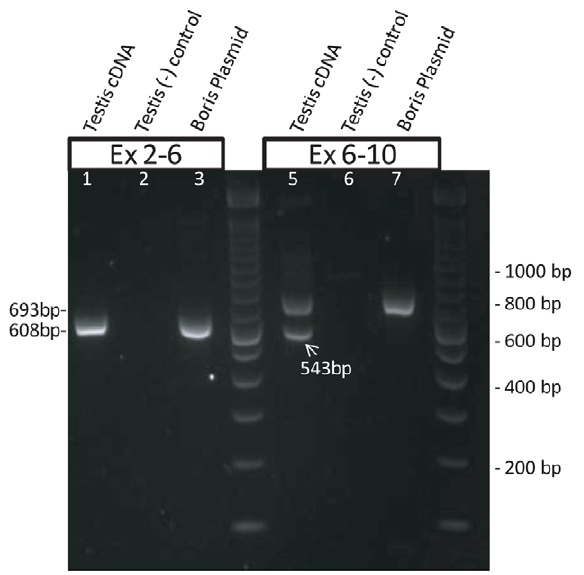
Figure 3. Expression of an alternatively spliced variant of BORIS in testis. BORIS specific primers, designed to amplify the region of BORIS between exons 2–6 (lanes 1–3) and exons 6–10 (lanes 5–7), were used to screen for possible alternatively spliced variants of BORIS . The expected sizes of these two products, based on the published sequence of mature BORIS mRNA, are 608 bp and 693 bp, respectively. These full- length products were present when testis cDNA (lane 1 & 5) and a plasmid containing a full length BORIS cDNA (lane 3 & 7) were used as PCR templates. In testis, an additional band (543 bp) was also amplified by the exon 6–10 PCR primers (lane 5). PCR products were not present